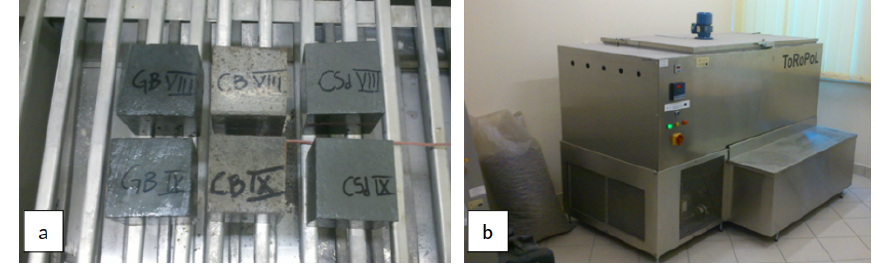
Figure 13. Test of frost resistance ( a ) samples in the chamber, ( b ) low-temperature